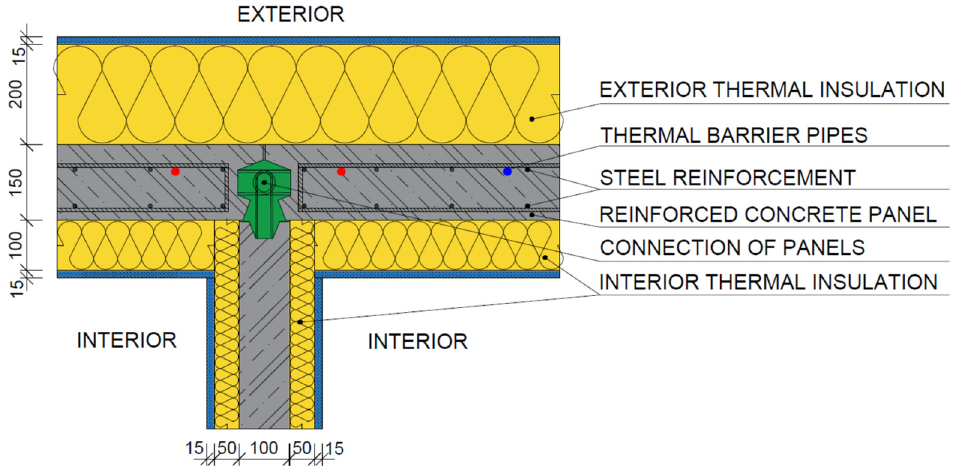
Figure 12. “Detail B”, the through joint of two perimeter panels. The colored points (red and blue) in the picture are thermal barrier pipes.